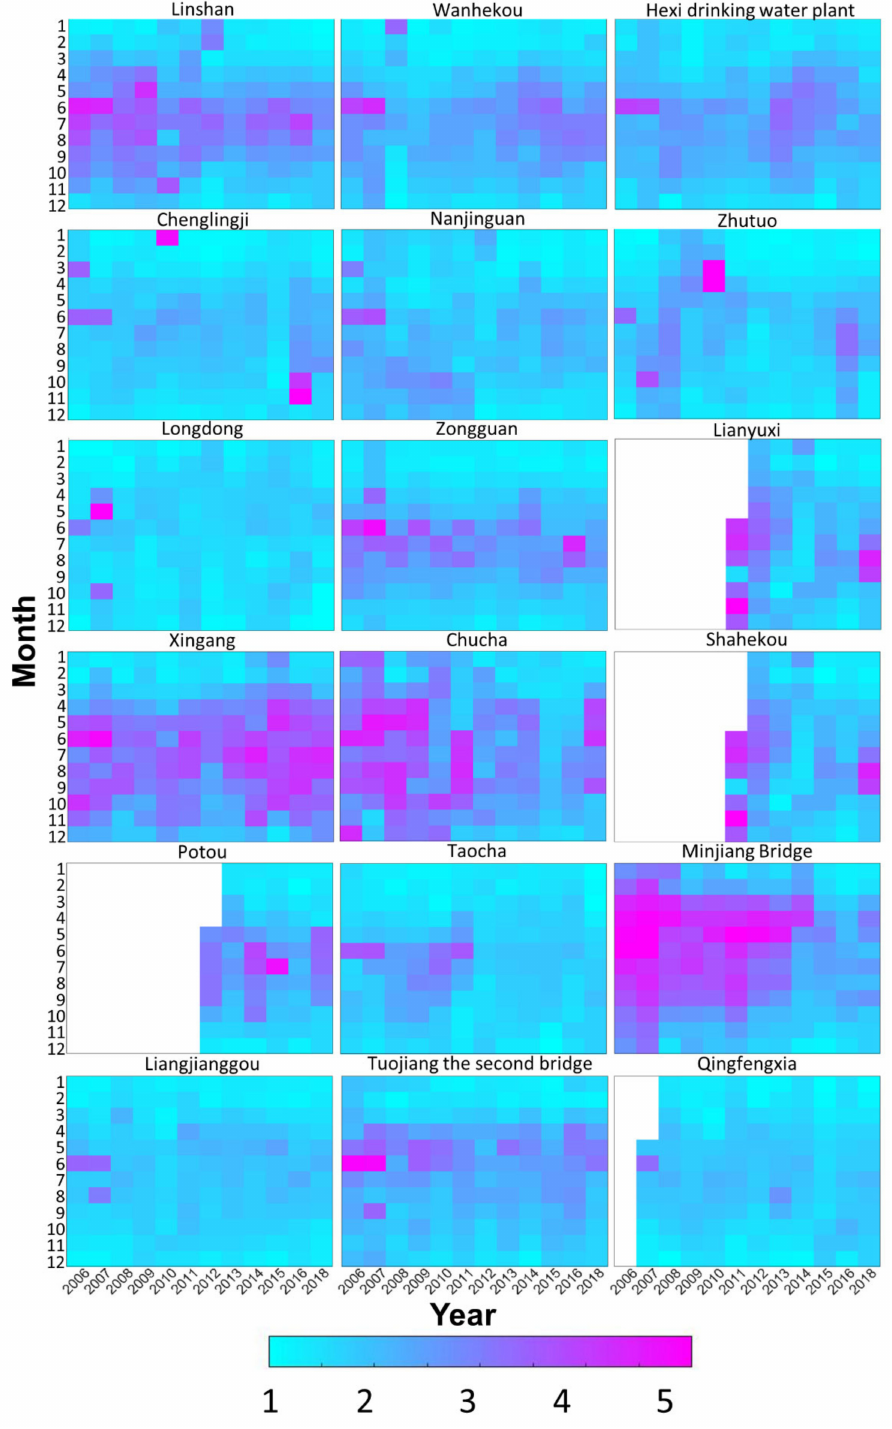
Figure 4. The monthly identification index of DO of each monitoring section (white block indicates lack of monitoring data). The first seven sites are the trunk